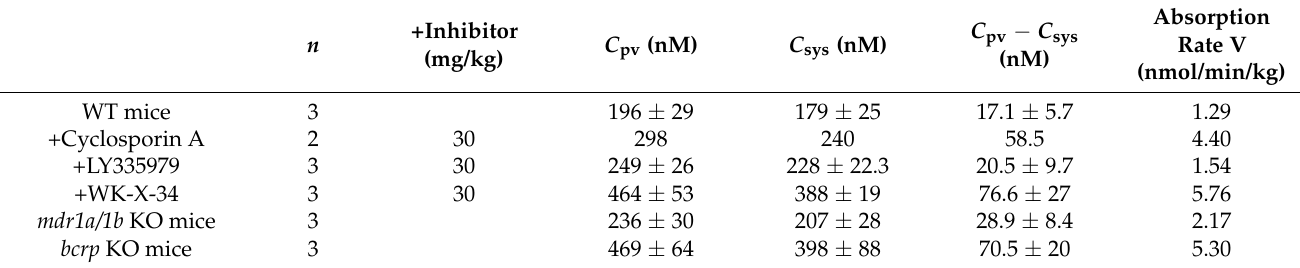
Table 6. Absorption rate of topotecan (2 mg/kg) at 30 min after its oral administration with or without P-gp inhibitor in WT, mdr1a/1b KO and bcrp KO